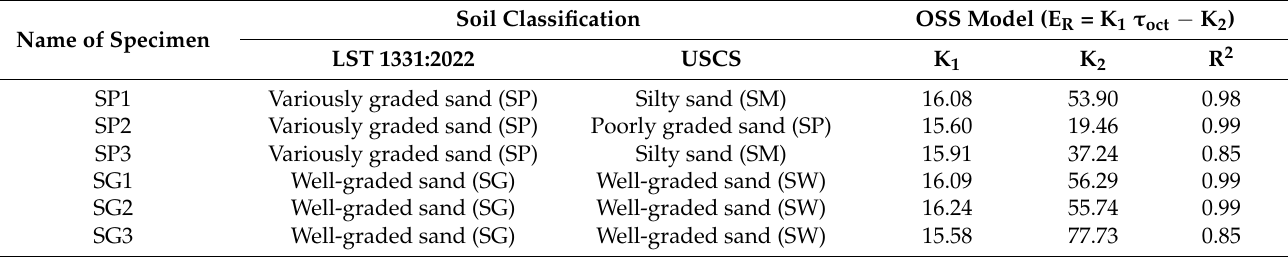
Table 8. The OSS models’ regression coefficients for specimens.